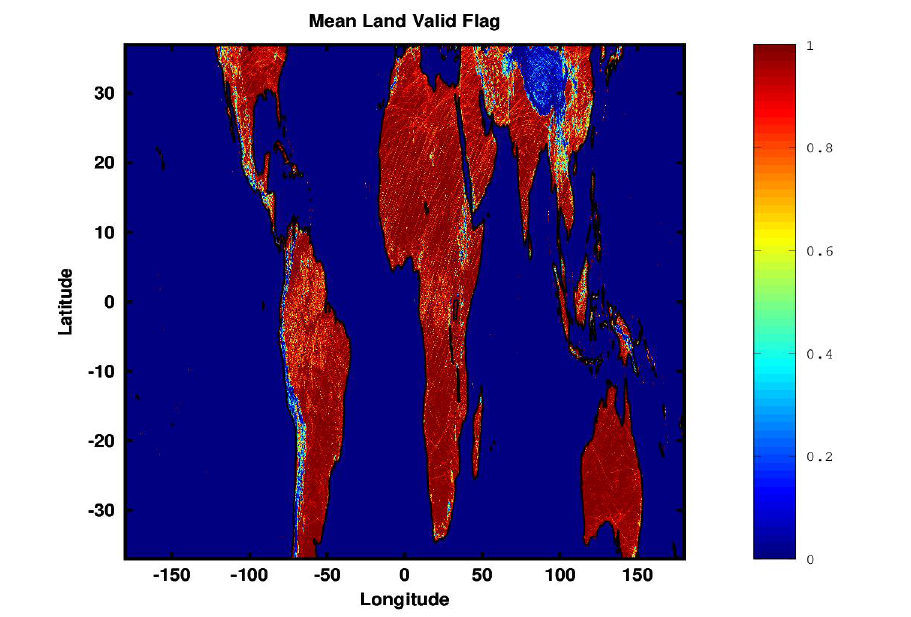
Figure 4. Map of mean land geolocation validity flag (0 or 1). Areas of lower validity correlate strongly with regions of high terrain variability. CYGNSS is unable to capture DDMS from the Tibetan Plateau and Andes Mountain regions.